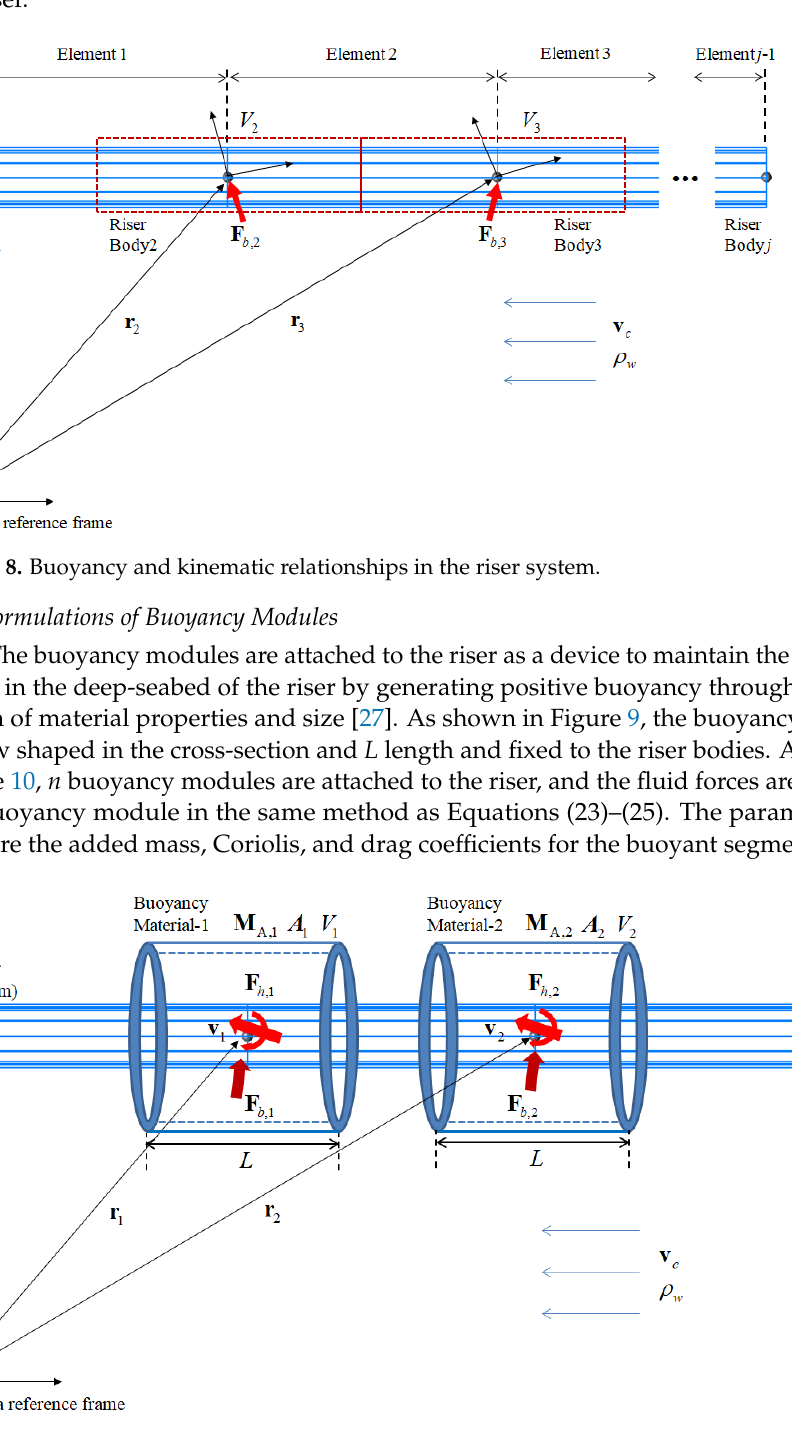
Figure 10. Buoyancy modules attached to riser system. 4.3. Formulations of Mining Vessel As shown in Figure 11, the six-directions motion (surge, sway, heave, roll, pitch, and yaw) of the mining vessel by ocean current (wave) can be represented by joint motions. The combination of three translational constraints and three rotational constraints makes the joint motion of a mining vessel possible. Translational and rotational constraint equa- tions are given by Equations (26) and (27), respectively [17,19]. 1 s rev